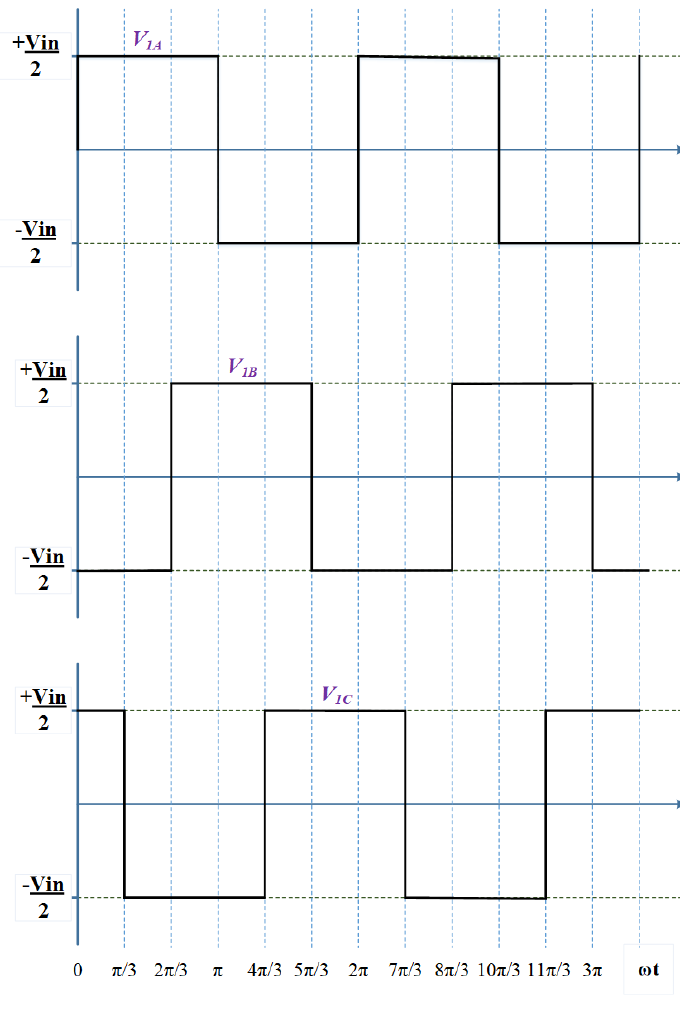
Figure 7. The primary-phase voltage waveform.